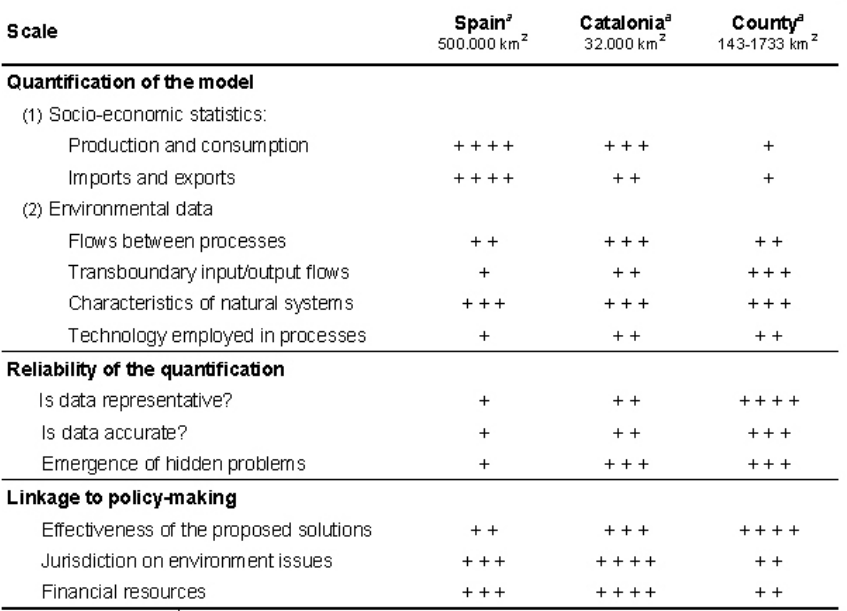
Summary of the Advantages of Three Geographical